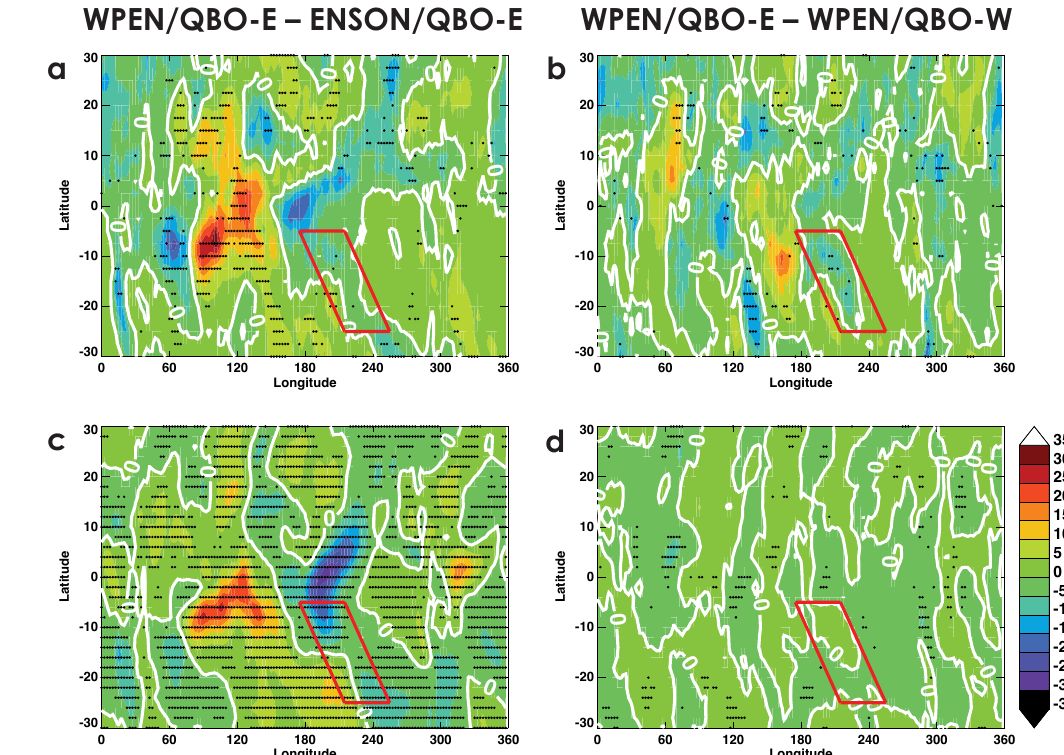
Fig. 6. Longitude-latitude contour plots showing SON seasonal mean OLR differences (Wm − 2 ) in (a, b) NOAA and (c, d) the GEOS CCM Figure 6. 2 simulations. The response to WPEN events during QBO-E is shown in (a) and (c) . The response to the QBO phase during WPEN events is shown in (b) and (d) . White contours indicate zero difference. Black Xs indicate regions where differences are significant at the 90% confidence level. Red boxes indicate the approximate Rossby wave source region found by Vera et al.